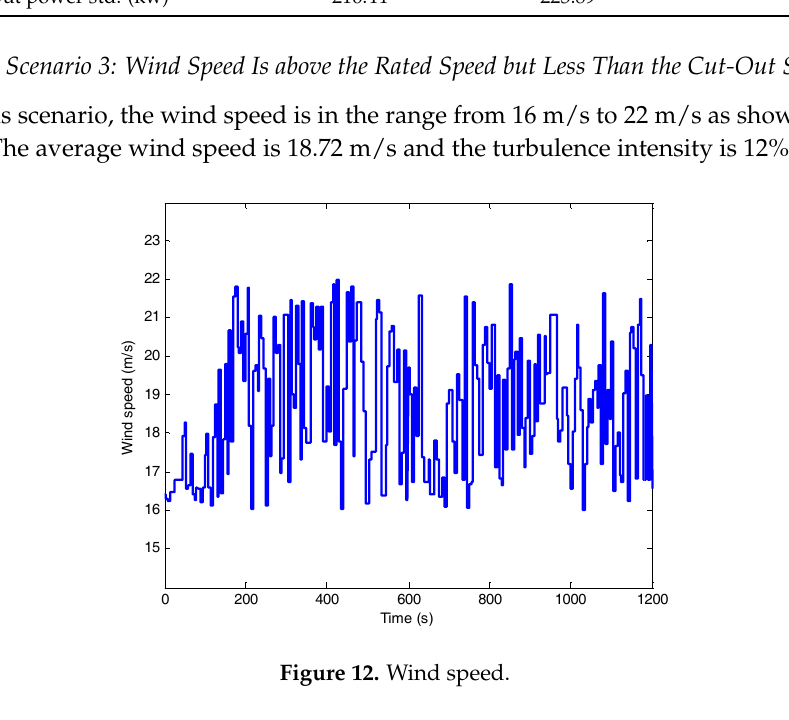
Table 4. Simulation results of turbine rotor speed, speed error and output power.